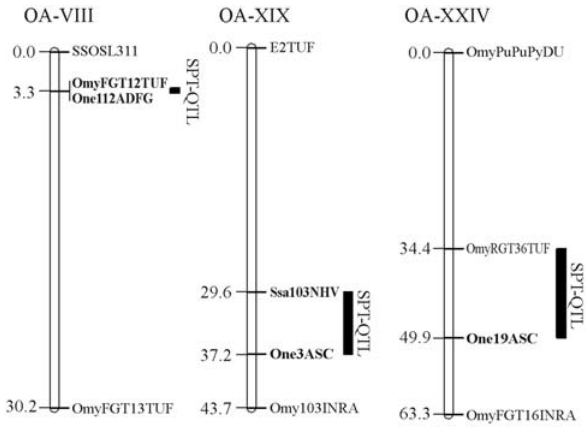
Figure 1 - Map positions of the markers linked to spawning time QTLs used in this work (indicated in bold). The map distance (in centiMorgans) betweenadjacentmarkersisshownontheleft.Thelocationsofthespawn- ing time QTLs (SPT-QTLs) are indicated by solid bars. Each linkage groupwasdefinedasproposedbyNichols etal. (2003).Linkagedatawere obtained from Sakamoto et al. (1999) and O’Malley et al.